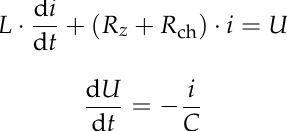
Figure 3. Equivalent circuit of high-voltage pulse instrument: S —high-voltage pulse switch; L , L 11 , L 21 , L 31 , L 41 , L 51 , L 61 , L 12 , L 22 , L 32 , L 42 , L 52 , L 62 —inductance; M 1 , M 2 , M 3 , M 4 , M 5 , M 6 —spark gap; C 1 , C 2 , C 3 , C 4 , C 5 , C 6 —capacitor.